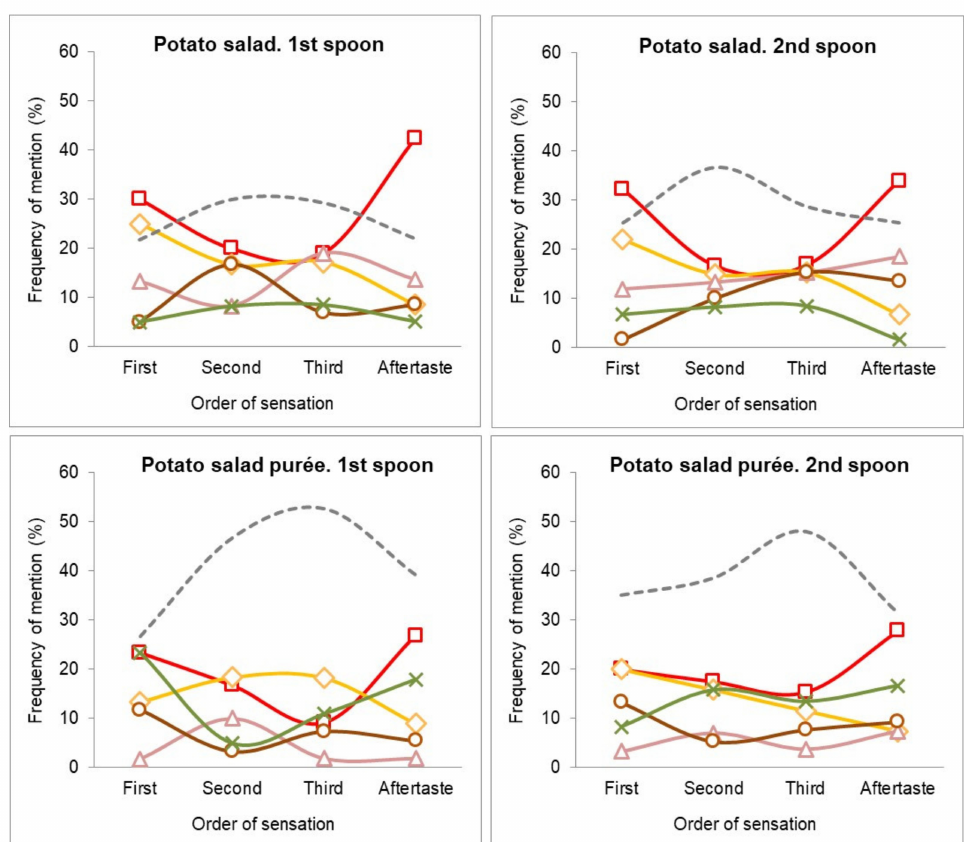
Figure 3. Free-TOS plots for potato salad dish and potato pur é e. Frequency of main mentioned flavors: tuna ( (cid:3) ); potato ( ♦ ); mayonnaise ( ∆ ); eggs ( ); green peas ( x ); and others ( — ) as first, second, or third sensation and aftertaste during the first (cid:35) and second